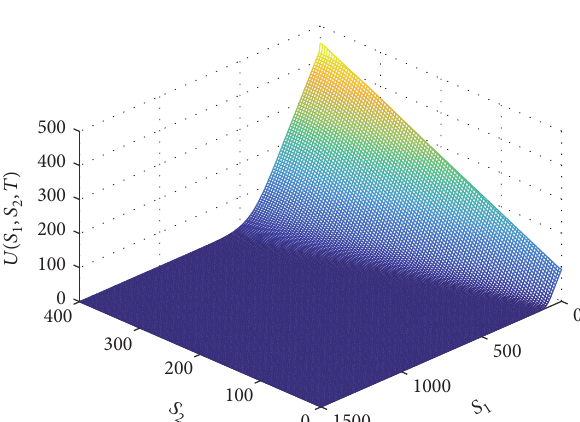
Figure 4: European spread put option with parameters